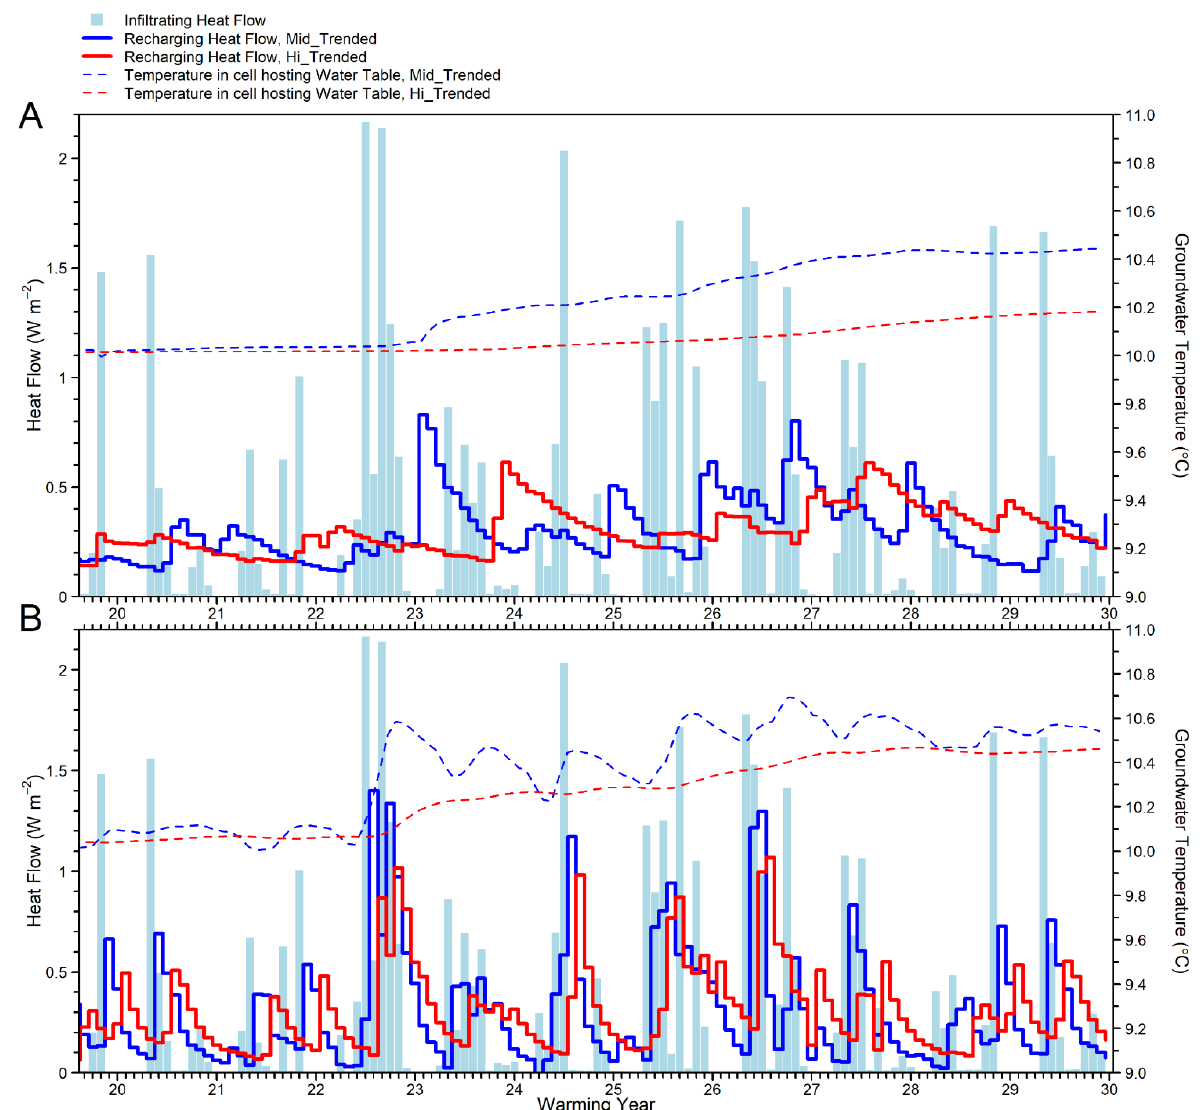
Figure 11. Convective heat flow (W/m 2 ) and temperature ( ◦ C) of the recharge at the ( A ) Upland and ( B ) Valley locations for the MID_TRENDED and HI_TRENDED simulations for the last 10 years of the warming period.